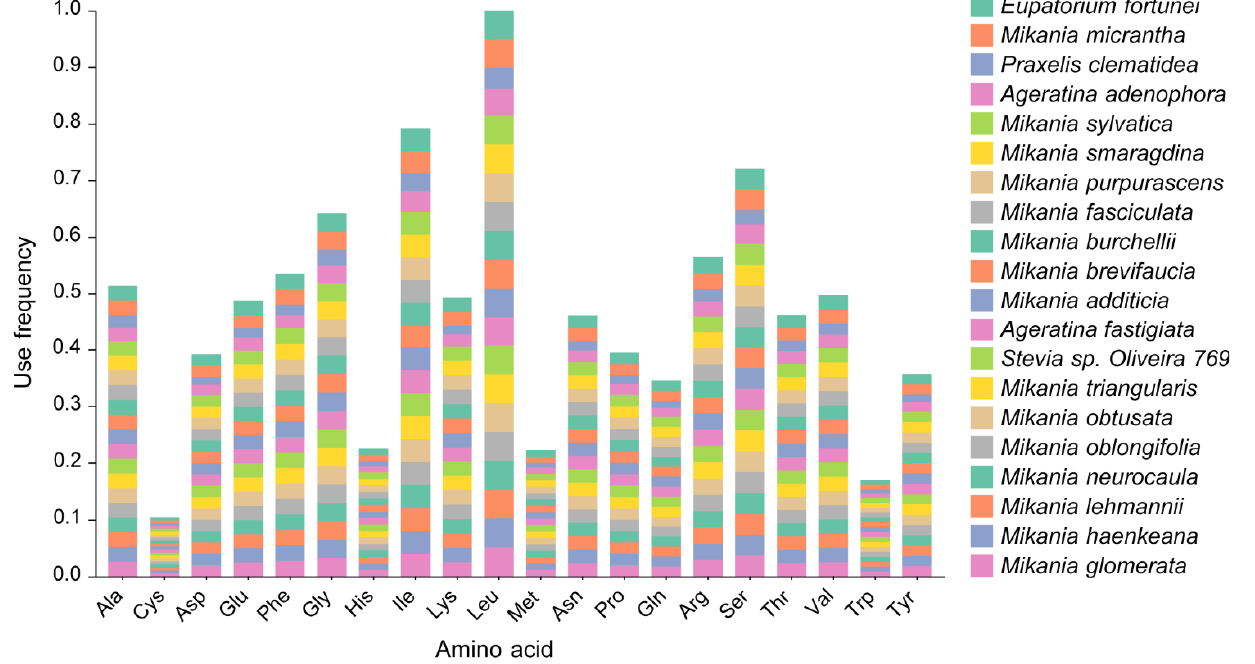
Figure 5. Frequency of amino acids encoded in the coding region by codons of chloroplast genes from 20 Eupatorieae species. Frequency: the relative frequency of codon (amino acid) used in different species. That is, the frequency of other codons relative to Leu using Leucine (Leu) as a benchmark.